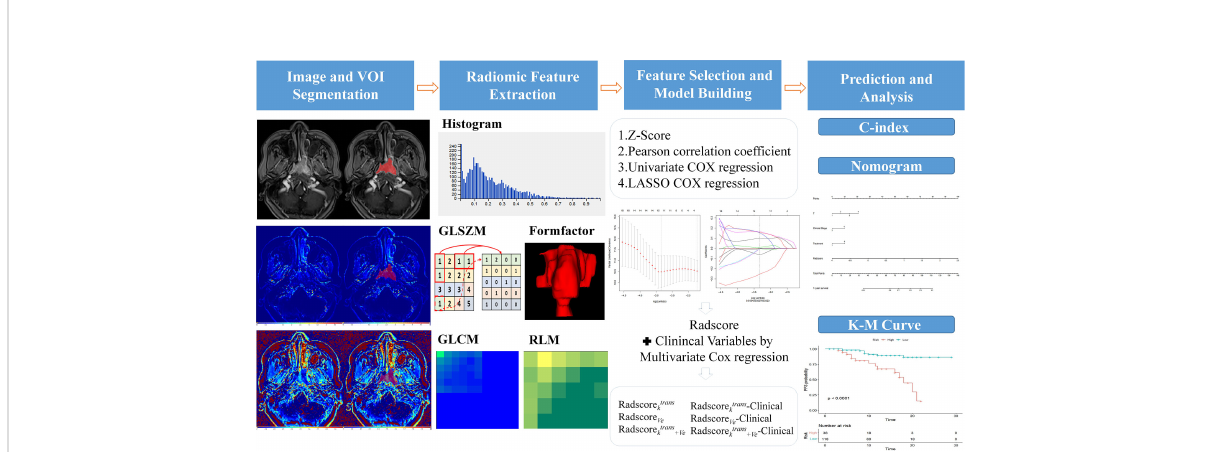
FIGURE 1 Work fl ow of radiomics analysis for predicting the prognosis of advanced nasopharyngeal carcinoma. The steps were: (1) Three-dimensional manual segmentation on K trans and V e images, (2) the calculation of six types of features for each patient from the de fi ned segmentation, (3) LASSO Cox regression for feature selection and data dimension reduction, and (4) multivariate Cox regression to develop a radiomics nomogram model. Kaplan-Meier analyses were then performed to assess the prognostic value of the model. Abbreviations: VOI, volume of interest; GLSZM, gray-level size zone matrix; GLCM, gray-level co-occurrence matrix; RLM, run-length matrix; LASSO, least absolute shrinkage and selection operator; C-index, Harrell ’ s concordance index; K – M curve, Kaplan – Meier analysis